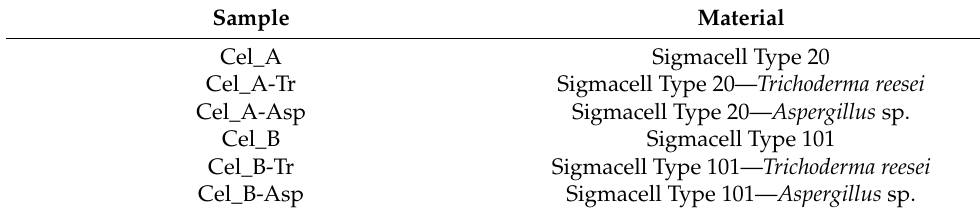
Table 1. Designations of obtained cellulose